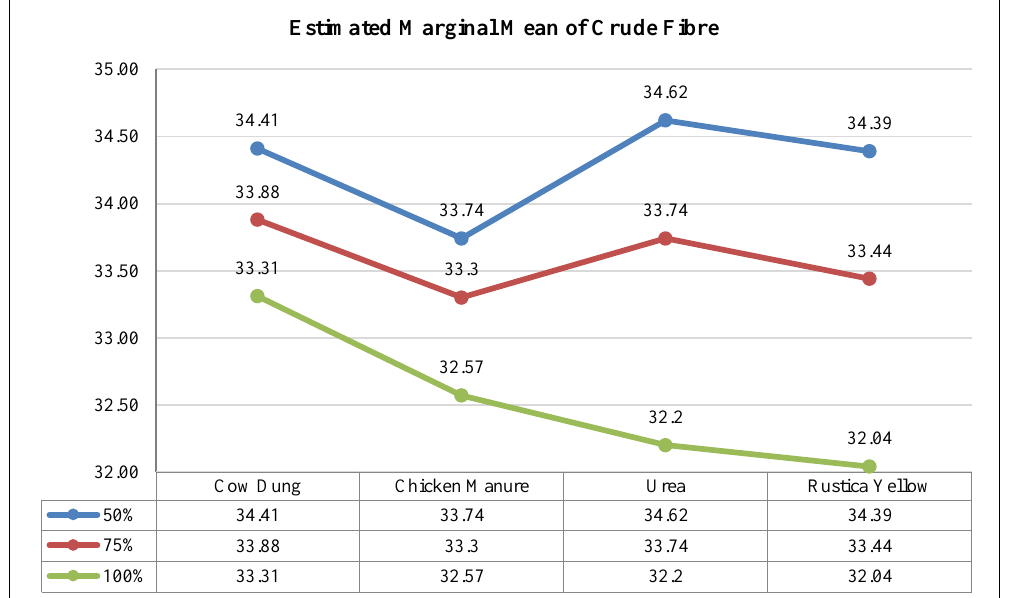
Estimated Marginal Mean of Crude